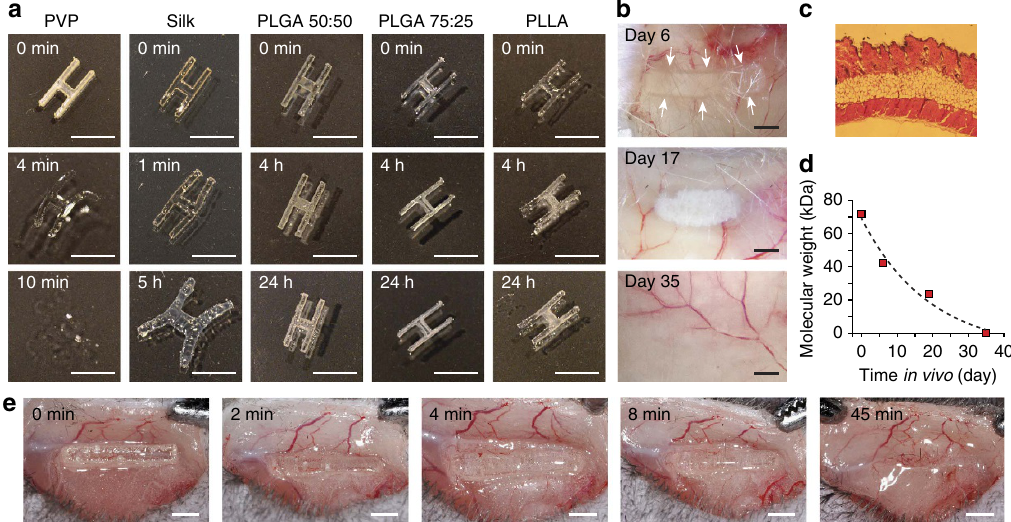
Figure 3 | Biodegradation of biopolymer-based waveguides. ( a ) Short-term behaviour of bio-polymer films are shown by immersing H-shaped waveguide samples into PBS. PVP dissolves within minutes. Silk deforms within minutes and shows considerable swelling after a few hours. PLGA and PLA largely retain their physical structure for more than 24h. Scale bars, 5mm. ( b ) Time-dependent in vivo degradation of 1 (cid:2) 5mm PLGA 50:50 polymer subcutaneously inserted into a mouse after 6, 17 and 35 days. No inflammation around the waveguide is observed. Scale bar, 1mm. ( c ) Histology image of skin tissue in the region where the polymer was implanted. ( d ) Average molecular weight of polymer chains in implanted bio-film as a function of degradation time ( N ¼ 1). Line, fit to exponential decay ( R 2 ¼ 0.93). ( e ) Dissolution of PVP waveguide in vivo